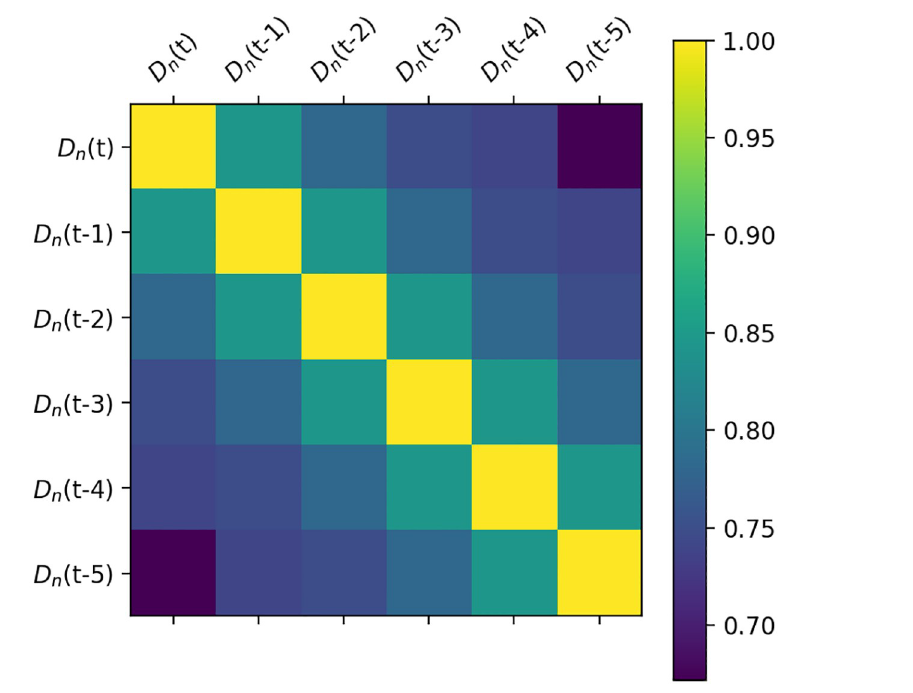
Fig 8. Taxi demand correlation analysis for different periods on a certain working day.